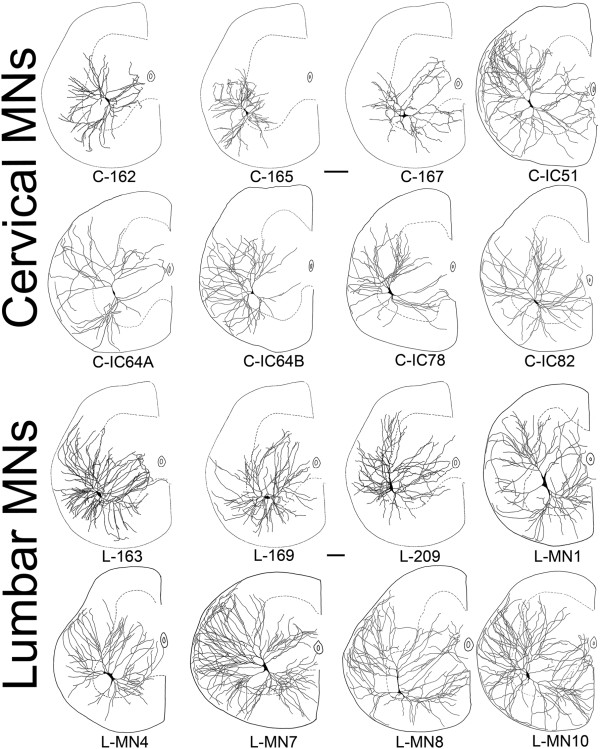
Camera lucida drawings of dendritic trees of fore- and hindlimb moving motoneurons (MNs) of frogs. Neurons are from the 3rd cervical and the 8th or 9th lumbar segments as seen in the transverse plane of the spinal cord. Drawings of MNs were superimposed with the contours of spinal cord to show locations of somata and direction and extent of dendrites. Dashed lines mark the border of white and gray matters. Scale bars are 100 μm. Part of this Figure was reprinted from
[10] and
[11] with permissions of the publishers Elsevier and John Wiley & Sons.